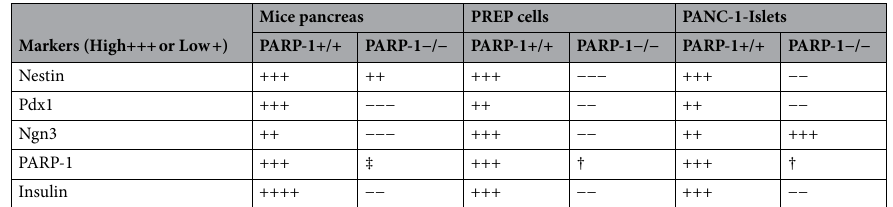
Markers (High+++ or Low